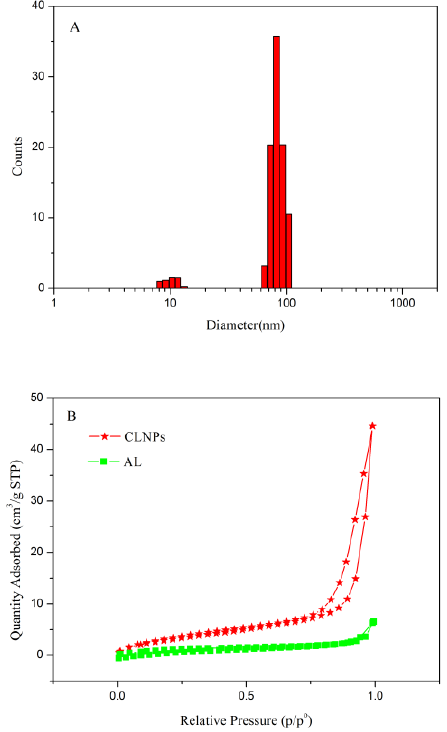
Figure 5. Particle size distribution of CLNPs ( A ) and nitrogen adsorption – desorption isotherms ( B ).